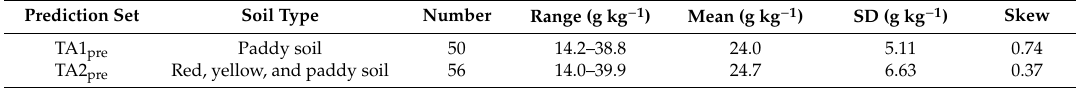
Table 2. Main characteristics of the two prediction